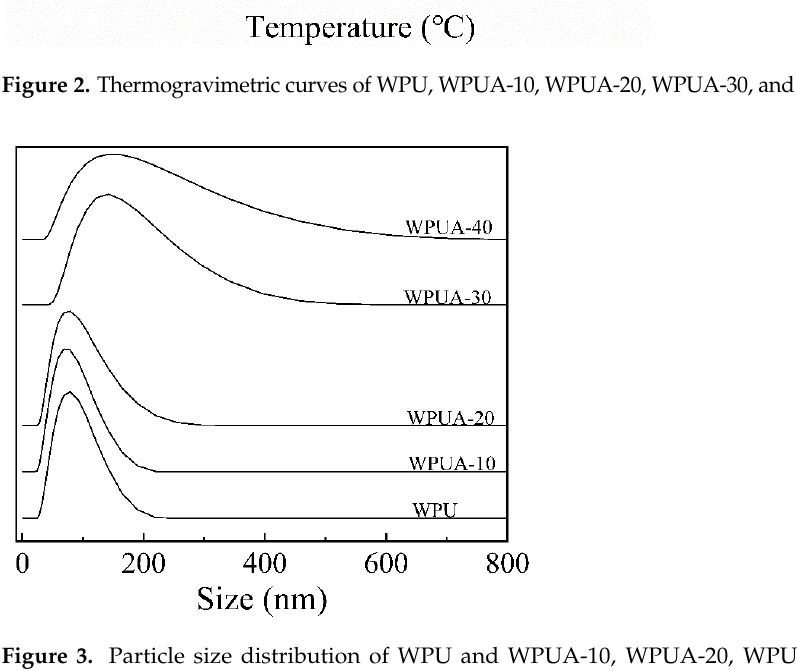
Figure 3. Particle size distribution of WPU and WPUA-10, WPUA-20, WPUA-30, and WPUA-40 emulsion.